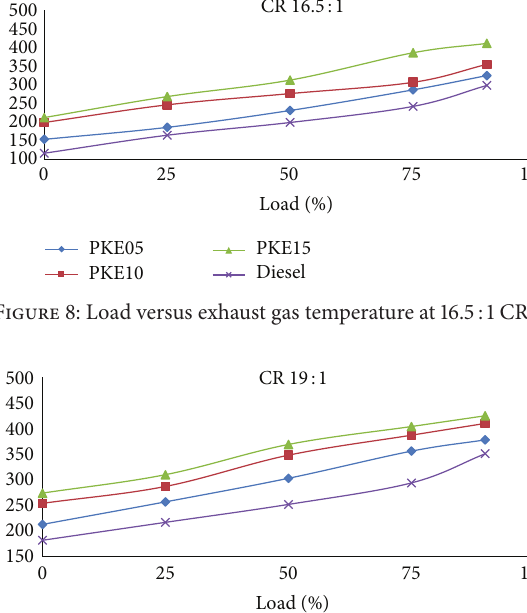
Figure 14: Load versus CO 2 emissions at 16.5: 1 CR.